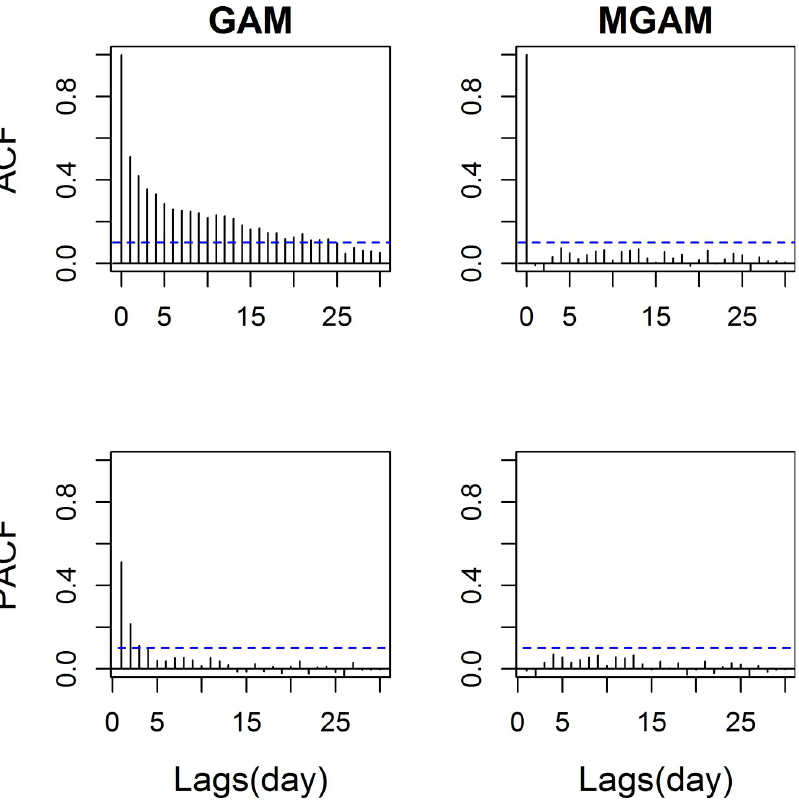
Fig 3. Autocorrelation function (ACF) and partial autocorrelation function (PACF) of GAM and MGAM model (df t = 5 and df temp =